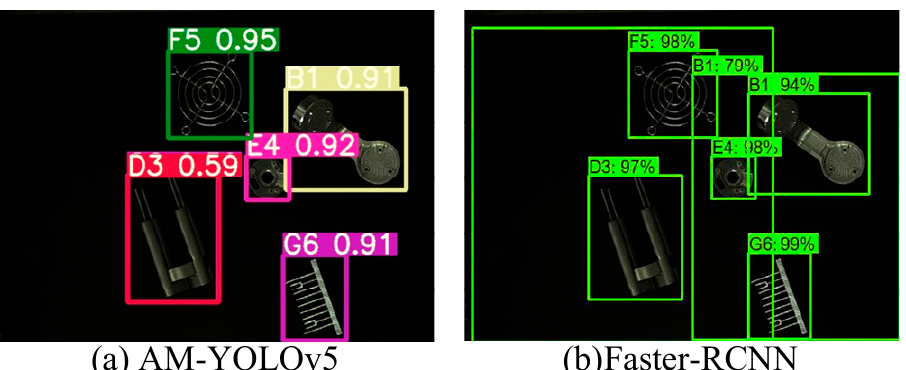
Figure 16. Results of AM-YOLOv5 and Faster-RCNN.